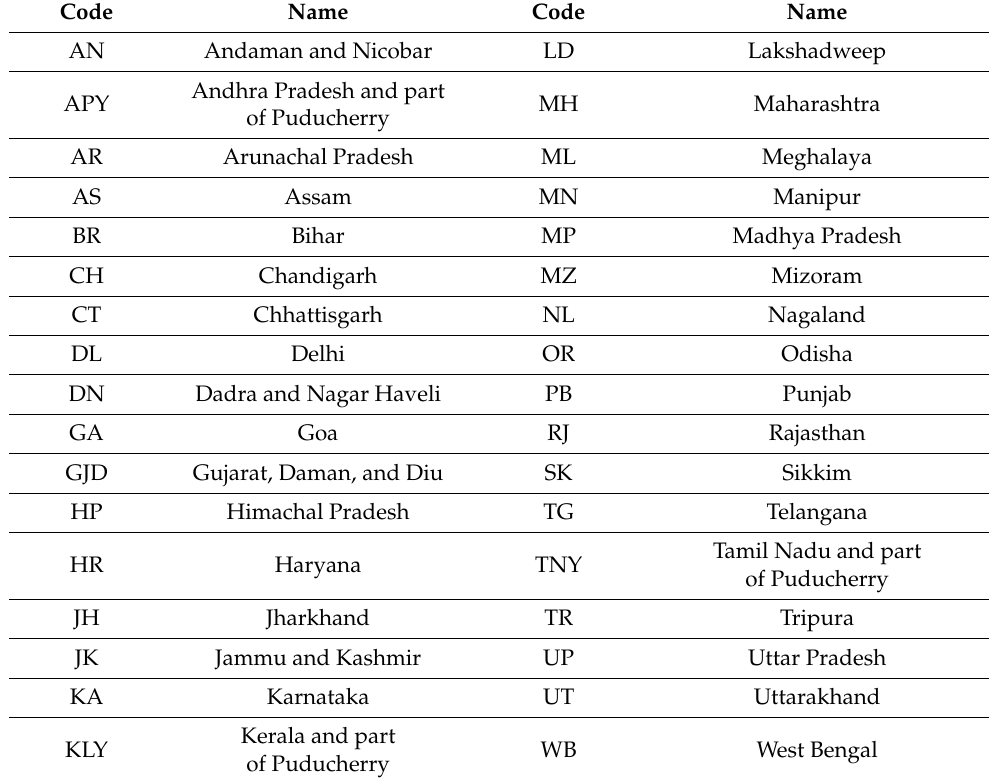
Table A1. Names of IDEEA regions, 34-region